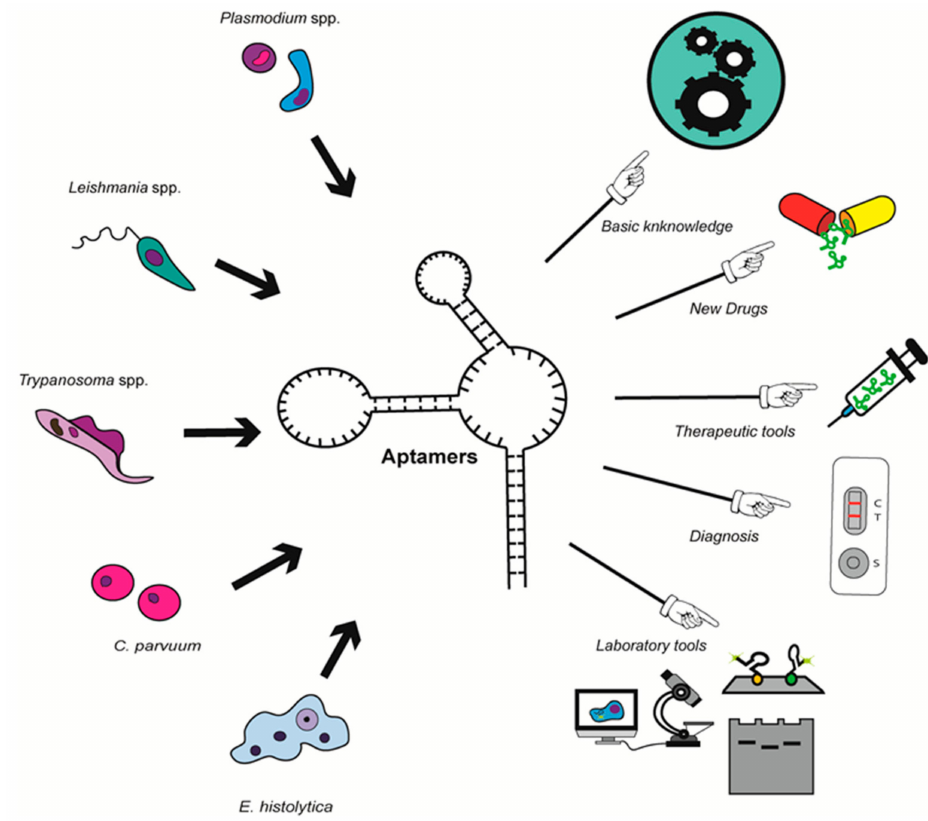
Figure 2. Potential applications for DNA/RNA aptamers against proteins of Plasmodium spp., Leishmania spp., Trypanosoma spp., C. parvuum and E. histolytica